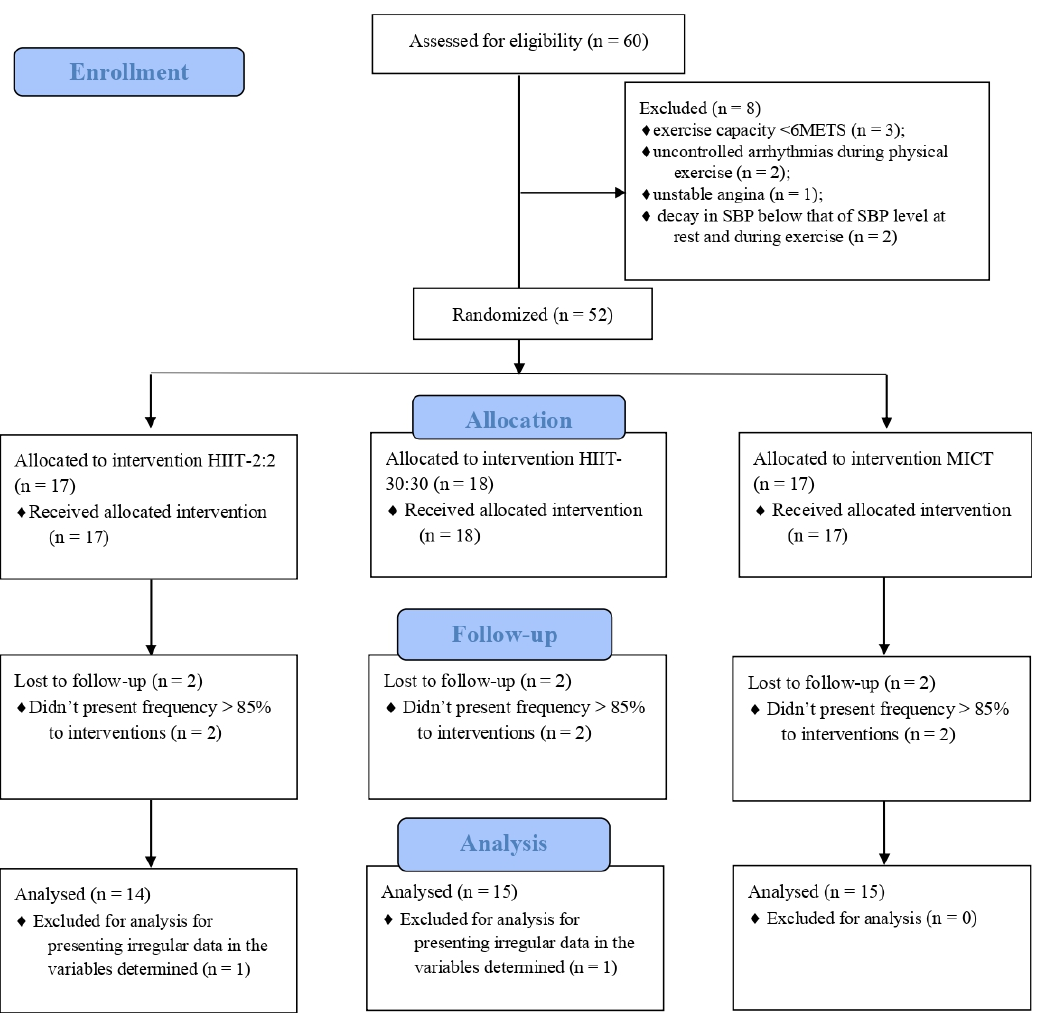
Figure 1. Study flow according to CONSORT recommendations. MICT: moderate intensity continuous training; HIIT: high-intensity interval training; SBP: sistolic blood pressure.